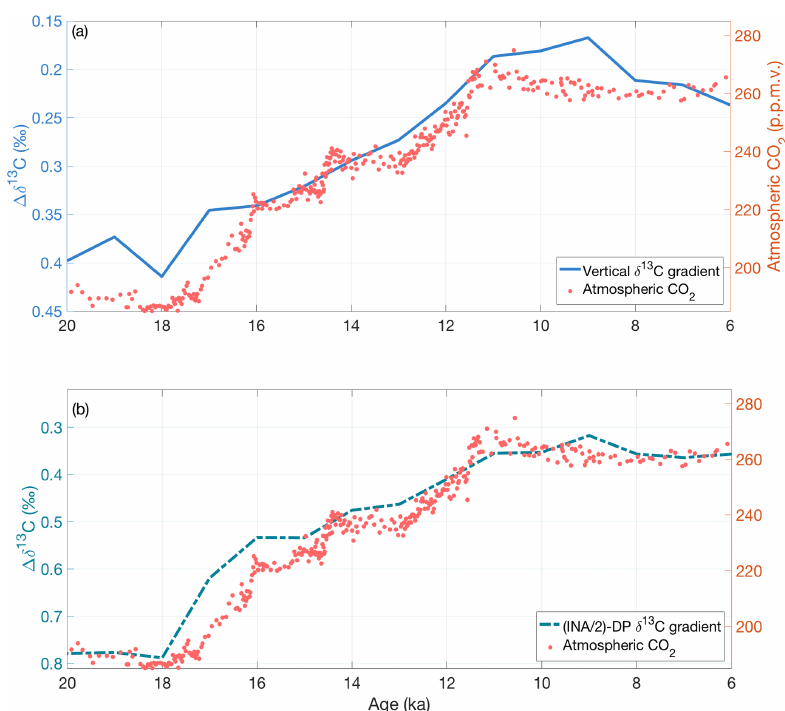
Figure 7. Comparison of atmospheric CO 2 with (a) the vertical δ 13 C gradient (excluding the data-sparse Indian Ocean regions) and (b) (cid:49)δ 13 C (INA / 2) − DP . Both gradients have a statistically significant correlation with atmospheric CO 2 records (red circles, Köhler et al., 2017). The y axes for (a) and (b) are scaled differently because (cid:49)δ 13 C (INA / 2) − DP scales the intermediate North Atlantic stack by half before subtracting the deep Pacific stack while the δ 13 C gradient is the difference between the intermediate and deep stacks (Atlantic and Pacific oceans